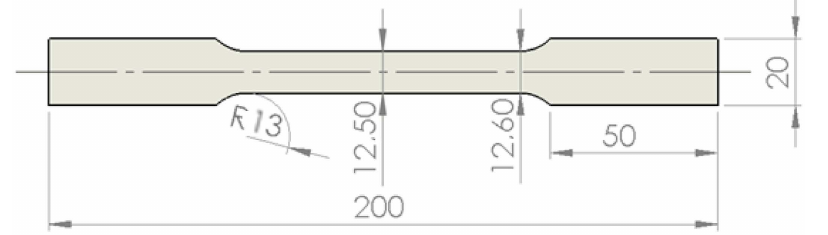
Figure 1. EK4 steel sample (dimensions in